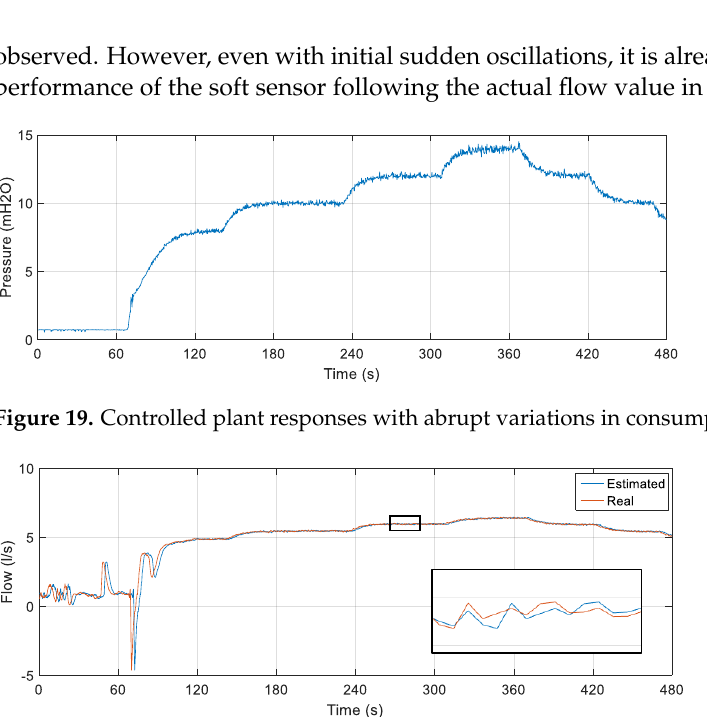
21 of 27 Figure 18. Estimated and real flow: Testing B. The curve of the value estimated by the soft sensor is very close to the flow curve (values measured by the electromagnetic flux transducer), as highlighted. Quantitatively and in standardizing tests for all validations, some statistical measures were taken regard- ing error tracking, and the results obtained are shown in Table 8. Table 8. Ratio between statistical measures: testing B. Error Average Maximum Error Standard Deviation 0.0059% 2.8093% 0.3763% The efficiency of the soft sensor allows the indirect measurement of flow to be carried out efficiently even with the possibility of spurious signals at its three inputs. It is ob-